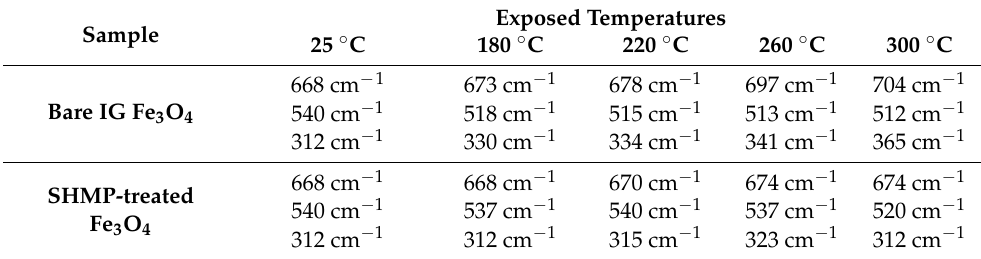
Figure 6. Raman spectra of bare and SHMP-treated Fe 3 O 4 samples calcined at ( a ) 180 ◦ C, ( b ) 220 ◦ C, ( c ) 260 ◦ C, and ( d ) 300 ◦ C compared with bare Fe 3 O 4 samples at room temperature, 25 ◦ C. Table 3. Raman shift (cm − 1 ) with assignment for bare IG-Fe 3 O 4 and SHMP-treated Fe 3 O 4 .